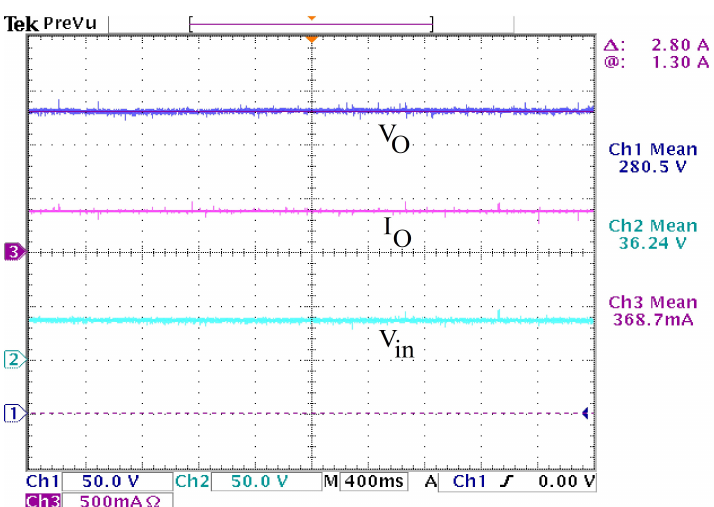
Figure 9. PSIM simulation of input and output voltages.